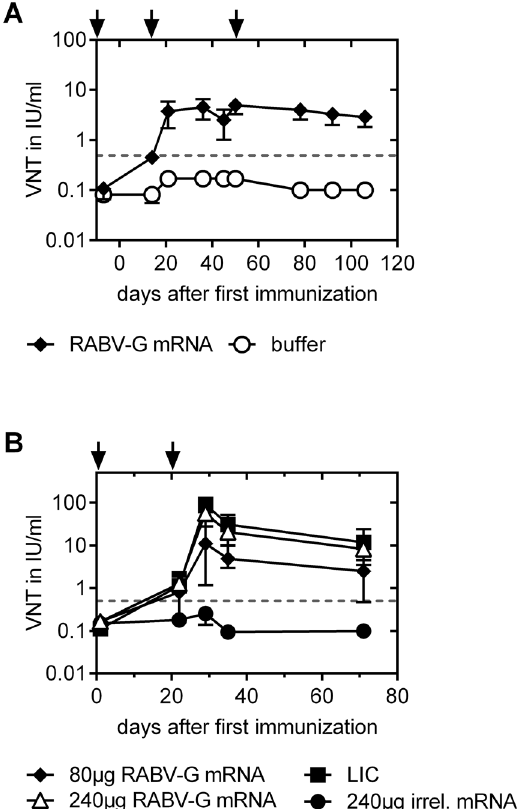
Fig 6. Seroconversion profile after RABV-G mRNA and Rabipur (LIC) vaccination in domestic pigs. Immunization points are indicated by arrows. (A) Adult pigs received intradermal immunizations on days 0, 14, 49 with either 80 μ g RABV-G mRNA or injection buffer alone. At different time points after immunization, sera were tested for rabies-specific neutralizing antibodies using FAVN testing (n = 6 pigs/group). (B) Newborn piglets were immunized in their first week of life and 3 weeks later with 80 μ g or 240 μ g RABV-G mRNA (i.d.) or a full human dose of Rabipur (LIC; i.m.). As a negative control, animals were immunized with 240 μ g of an irrelevant mRNA. At different time points blood samples were taken and sera were tested for virus-neutralizing antibodies using the FAVN test (n = 5 or n = 6 (240 μ g) piglets/group). In both graphs mean and SD is